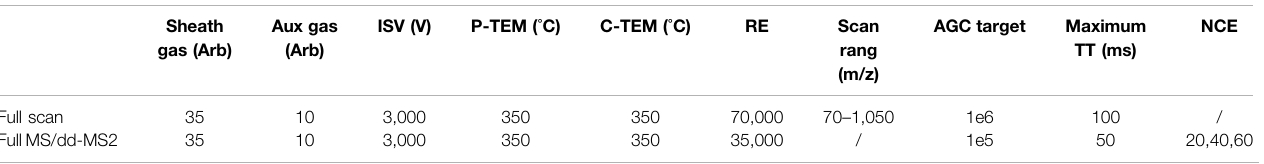
TABLE 2 | Instrument-dependent parameters settings for quali fi cation of ASD and